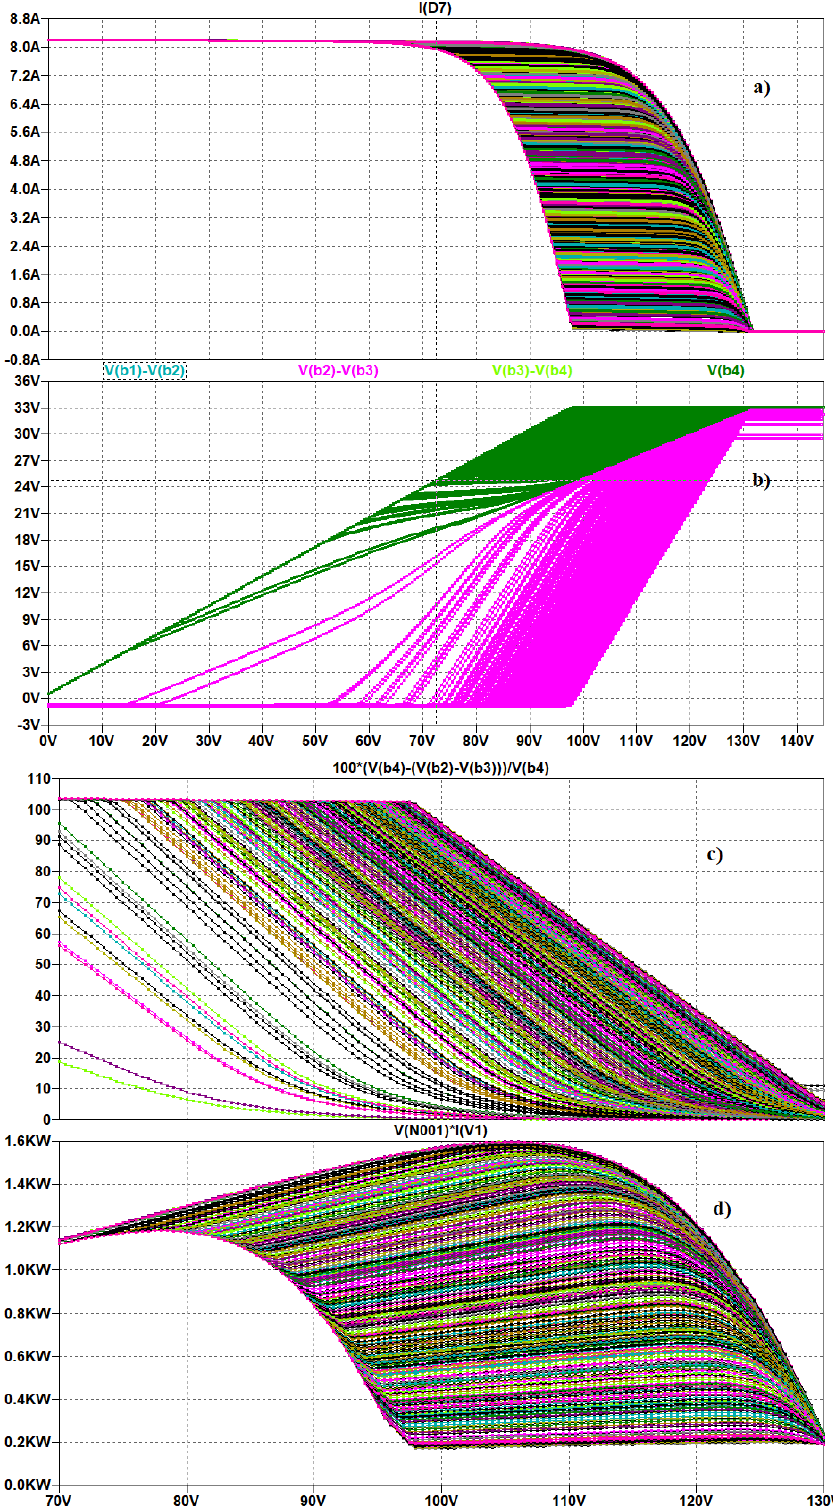
Figure A5. Micro cracks faults. This figure shows four charts as following: ( a ) the current of the affected string versus the operation voltage of the array, ( b ) the differential voltage for all the modules in the affected string, ( c ) the relative percentage difference versus the operating voltage of the array, ( d ) peak behavior of output power in the